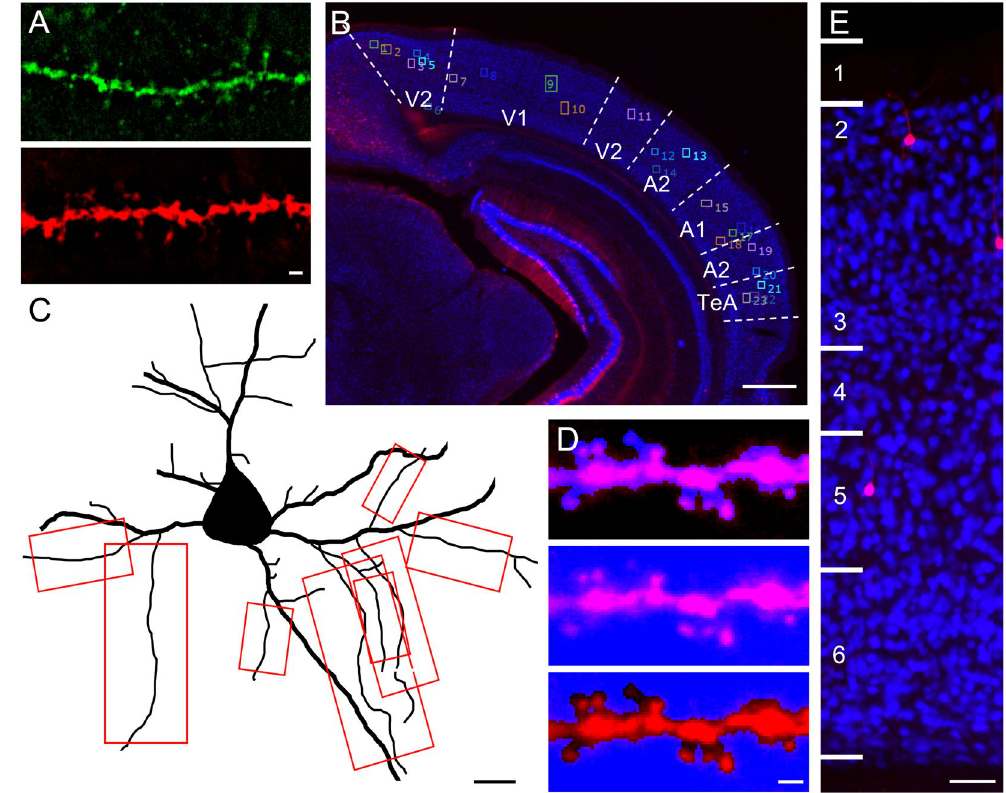
Figure 3. Immunohistochemical, sampling and image processing methods. ( A ) Fluorescent signal amplification using an AlexaFluor 568 secondary antibody (bottom panel) achieved superior SNR characteristics compared to amplification with AlexaFluor 488 (top panel) after no-neighbors smoothing. Scalebar = 1 μ m. ( B ) Numbering strategy for fluorescent pyramidal cells in ROI of a representative 60 μ m thick tissue section corresponding to plate 59 in Franklin and Paxinos’s The Mouse Brain In Stereotaxic Coordinates [49]. ROI comprises the following regions, clockwise from top left: mediomedial and mediolateral secondary visual cortex (V2), monocular and binocular primary visual cortex (V1), lateral secondary visual cortex (V2), dorsal secondary auditory cortex (A2), primary auditory cortex (A1), ventral secondary auditory cortex (A2) and temporal association cortex (TeA). Numbered neurons were imaged in random order. Scalebar = 500 μ m. ( C ) Illustration of pyramidal cell with all secondary minor basal dendritic segments outlined in red meeting criteria for segment inclusion ( > 10 μ m from soma and >= 3 μ m from dendrite branch point or termination). Scalebar = 10 μ m. ( D ) Quantitative strategy used to exclude dim dendritic segments. 10 μ m sampling area of each dendritic segment assayed was masked in SlideBook 6. Top panel shows manually generated mask using thresholding and the brush tool for “signal” of the dendritic segment. Middle panel shows the mask covering 100% of the pixels in the capture window. Bottom panel shows the mask created using the masks in the 2 panels on the left and Boolean math. This mask represents the “noise.” SNR was calculated as mean intensity of the signal divided by mean intensity of the noise. SNR for the segment in this example = 3.205. Segments with SNR > 2 were included in data analysis. Scalebar = 1 μ m. ( E ) Assessment of NeuN labeling in 10x images were used to estimate region and determine laminar location of cell bodies of red fluorescent pyramidal cells. This example from region A2. Scalebar = 50 μ